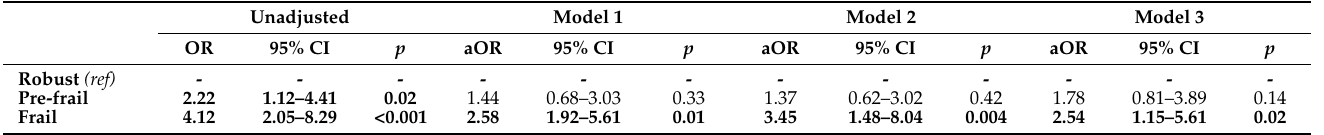
Table 3. Association between frailty and non-use of the Internet.